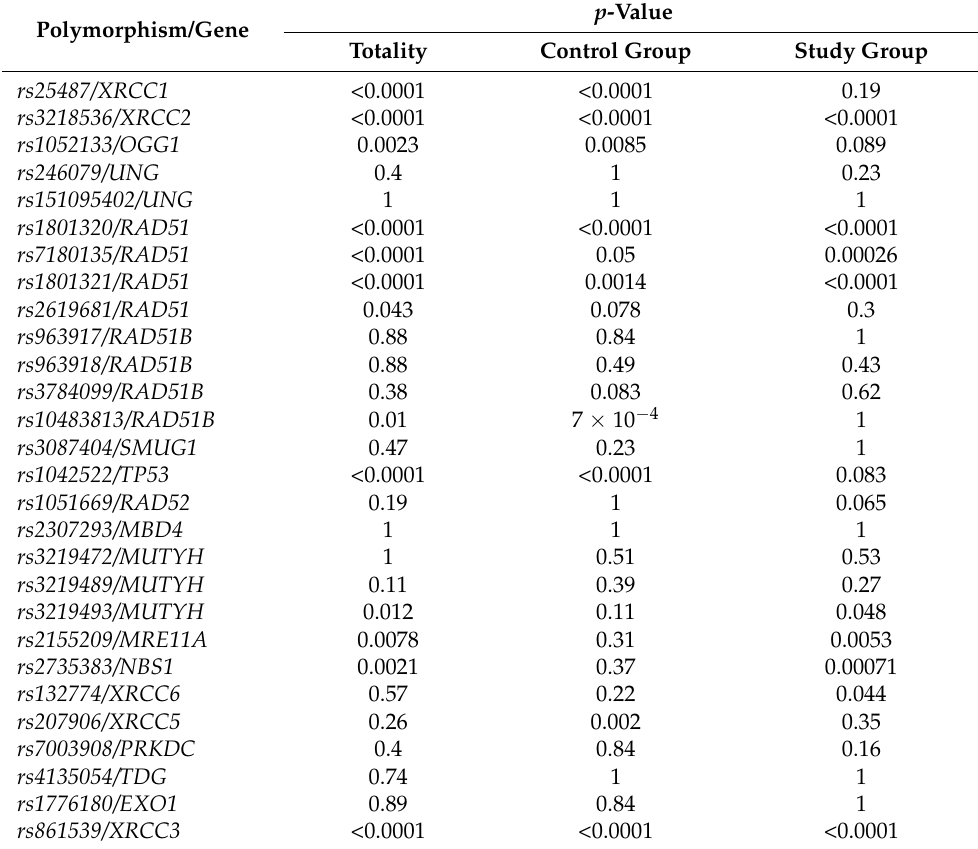
Table 2. The Hardy–Weinberg Equilibrium analysis.